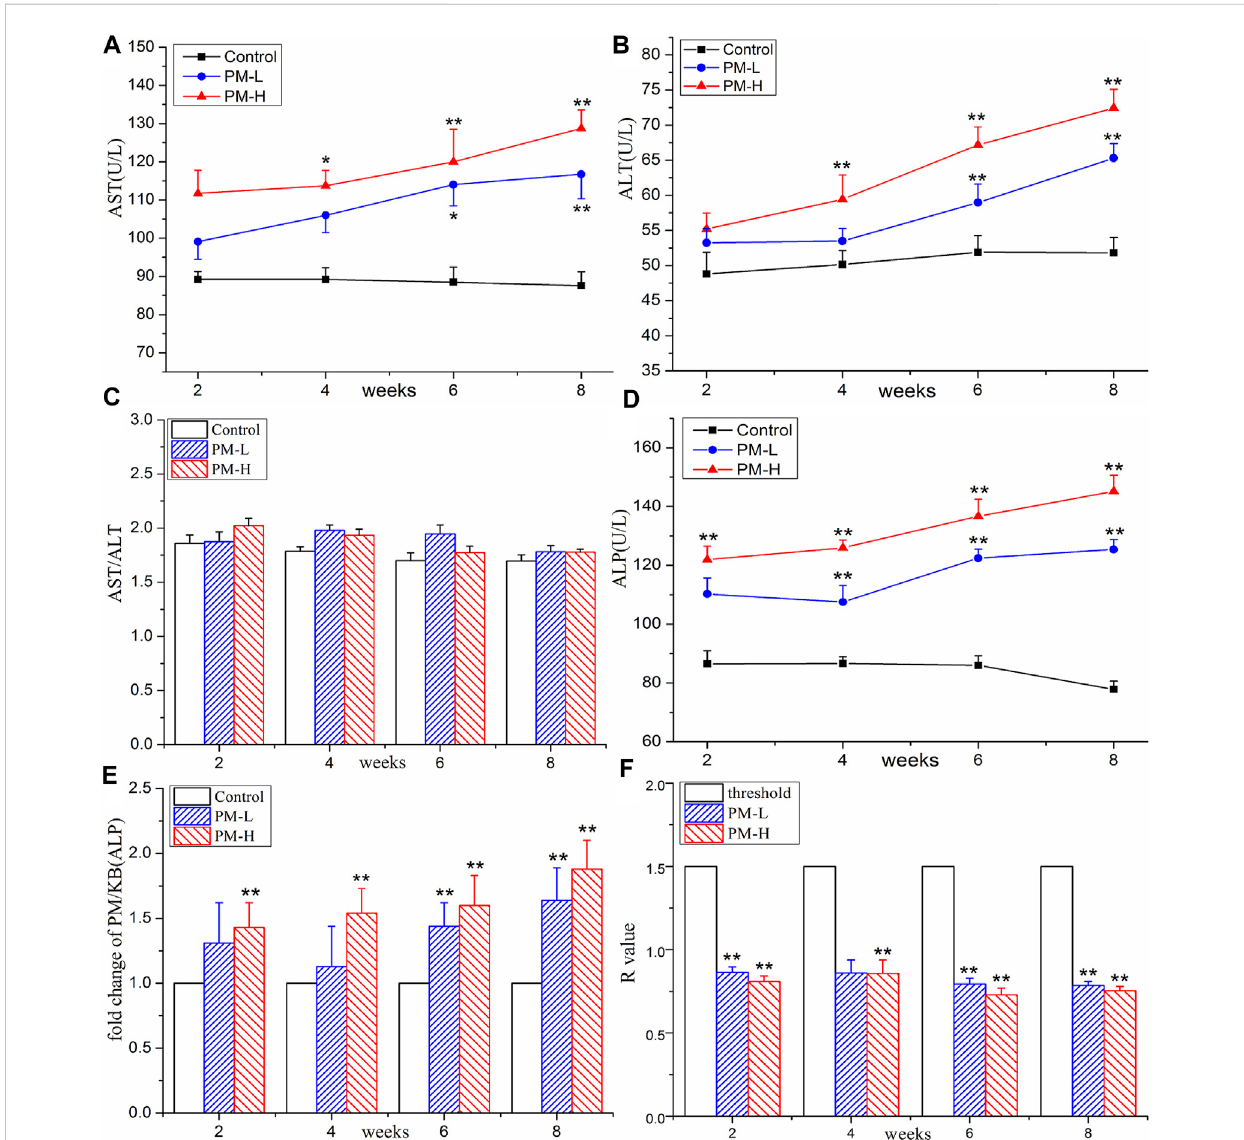
FIGURE 2 Contents of AST (A) , ALT (B) , AST/ALT ratio (C) , ALP (D) , fold change of ALP (E) and R values (F) in Control, PM-L and PM-H group at the end of second, fourth, sixth and 8 week after administration. (mean ± SEM, n = 8, * p < 0.05, ** p <